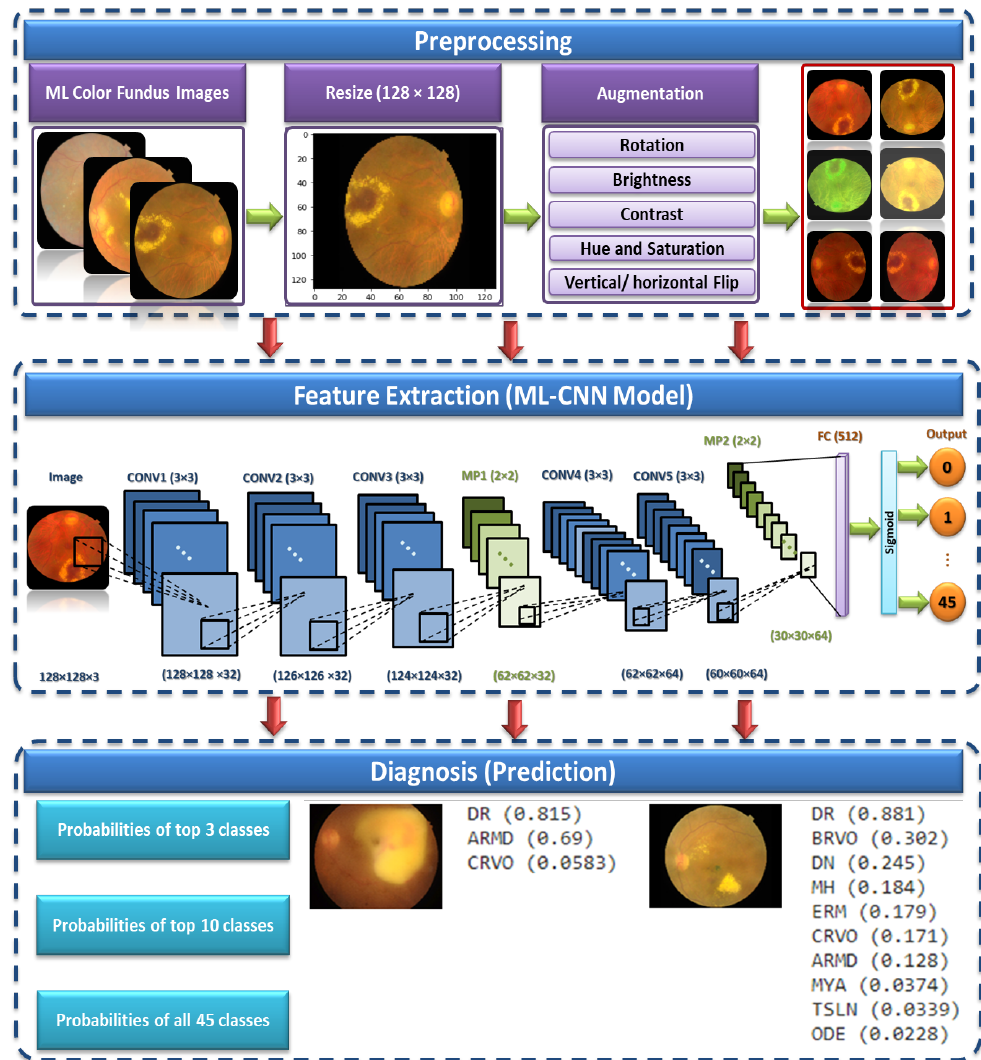
Figure 2. The proposed ML CAD system for detecting and diagnosing various ODs from ML color fundus